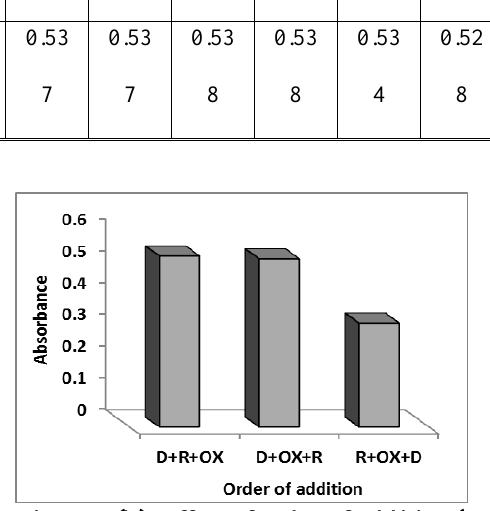
Table 1. The effect time of reaction Time,